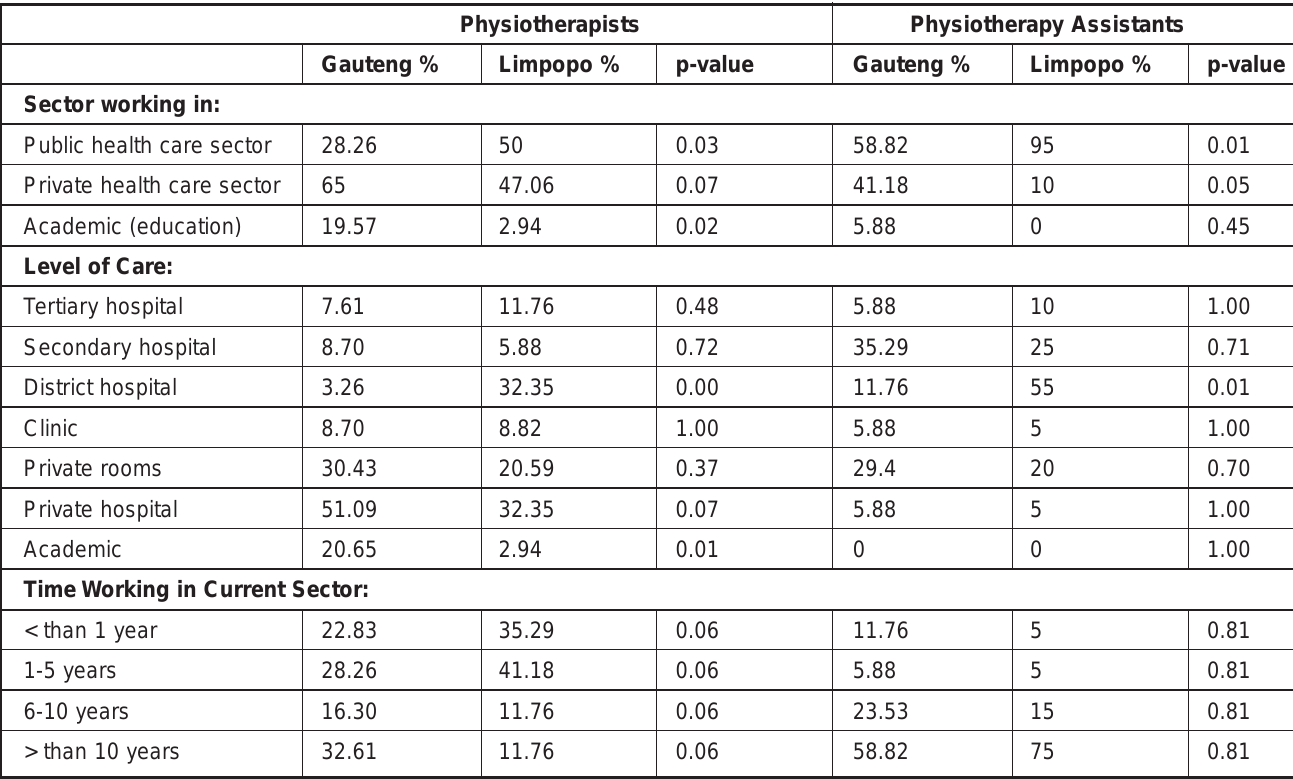
Table 1: Work sector of physiotherapists and assistants